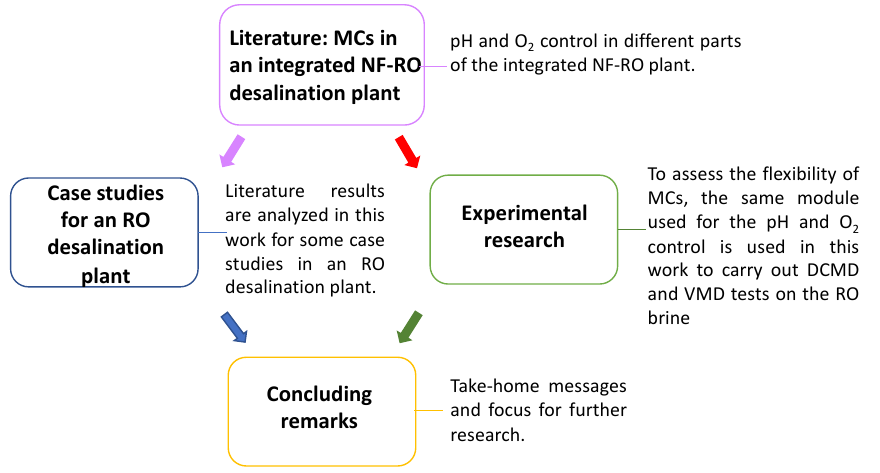
Figure 4. Main steps followed in this work.